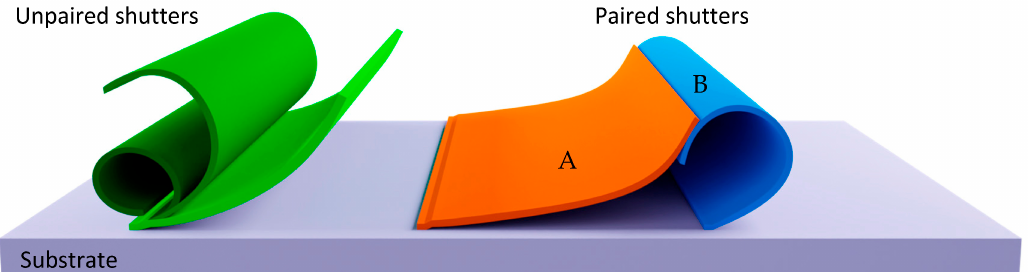
Figure 3. Two fundamentally different geometries of the shutter blades: ( left ) unpaired with different optional curling states and ( right ) pairing of curled shutter blades A and B. The colour code used is explained in Section 4.